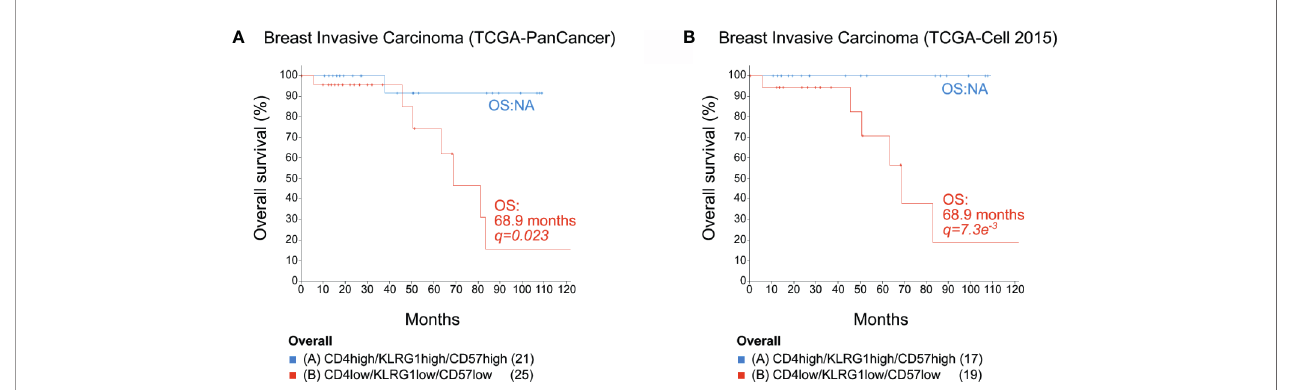
FIGURE 6 | Overall survival for breast cancer patients. Expression data from two TCGA breast invasive carcinoma cohorts were analyzed using cBio Cancer Genomics Portal (http://cbioportal.org). The overall survival (OS) of patients was calculated in accordance with the level of mRNA expression (low or high) of CD4, KLRG1, and B3GAT1 (CD57) (mRNA expression z-scores relative to all samples (logRNAseqs V2 RSEM). (A) TCGA-PanCancer Cohort. (B) TCGA-Cell 2015 cohort. NA, not analyzed when less than 50% of the patients died. Statistical analysis by log rank Test p and q. The number of patients in each selected population is indicated in parenthesis in each KM